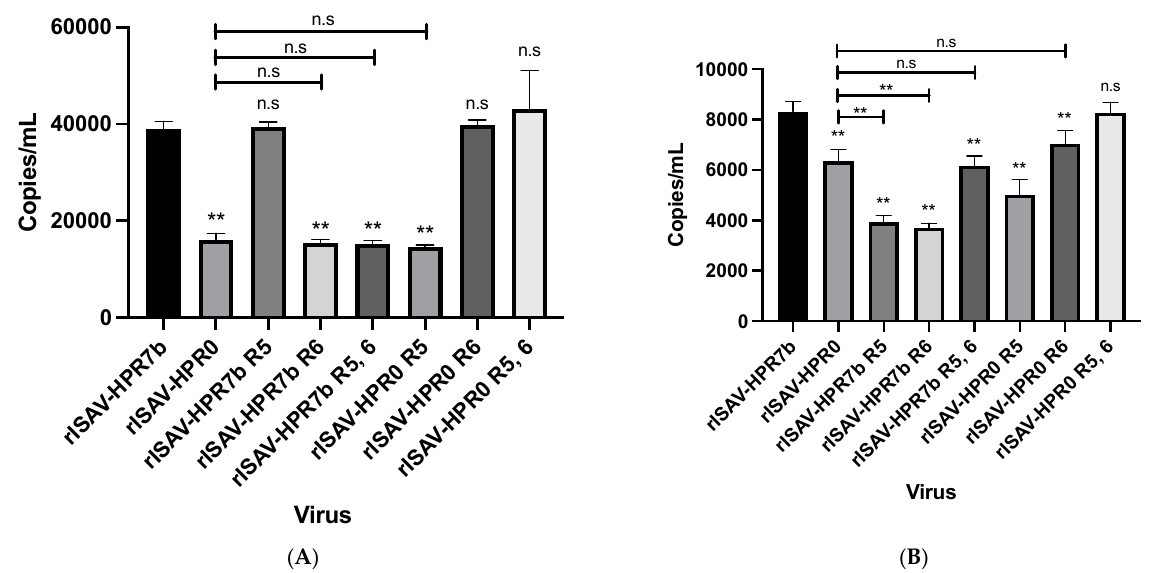
Figure 7. rISAV quantification assay to determine the effect of segments 5 and 6 genotype on the early and late steps of adsorptions and uptake. ( A ) Absolute quantification of ISAV segment 8 copy number of the isavirus attached, and uptake at 1 hpi from ASK cells infected at an MOI of 1. ( B ) Absolute quantification of isavirus segment 8 copy number at 2 hpi from washed ASK cells infected at an MOI of 1. Copies/mL ± SEM from three independent experiments. α = 0.05; ** p < 0.005; n.s. not significant. Table 4. Fold induction of IFN- α , Mx, and ISG15 genes at 72 hpi. ASK cells were infected, and an MOI of 0.1 and cellular RNA were extracted at 72 hpi. Gene expression was determined by qRT-PCR using the 18S ribosomal gene as the housekeeping